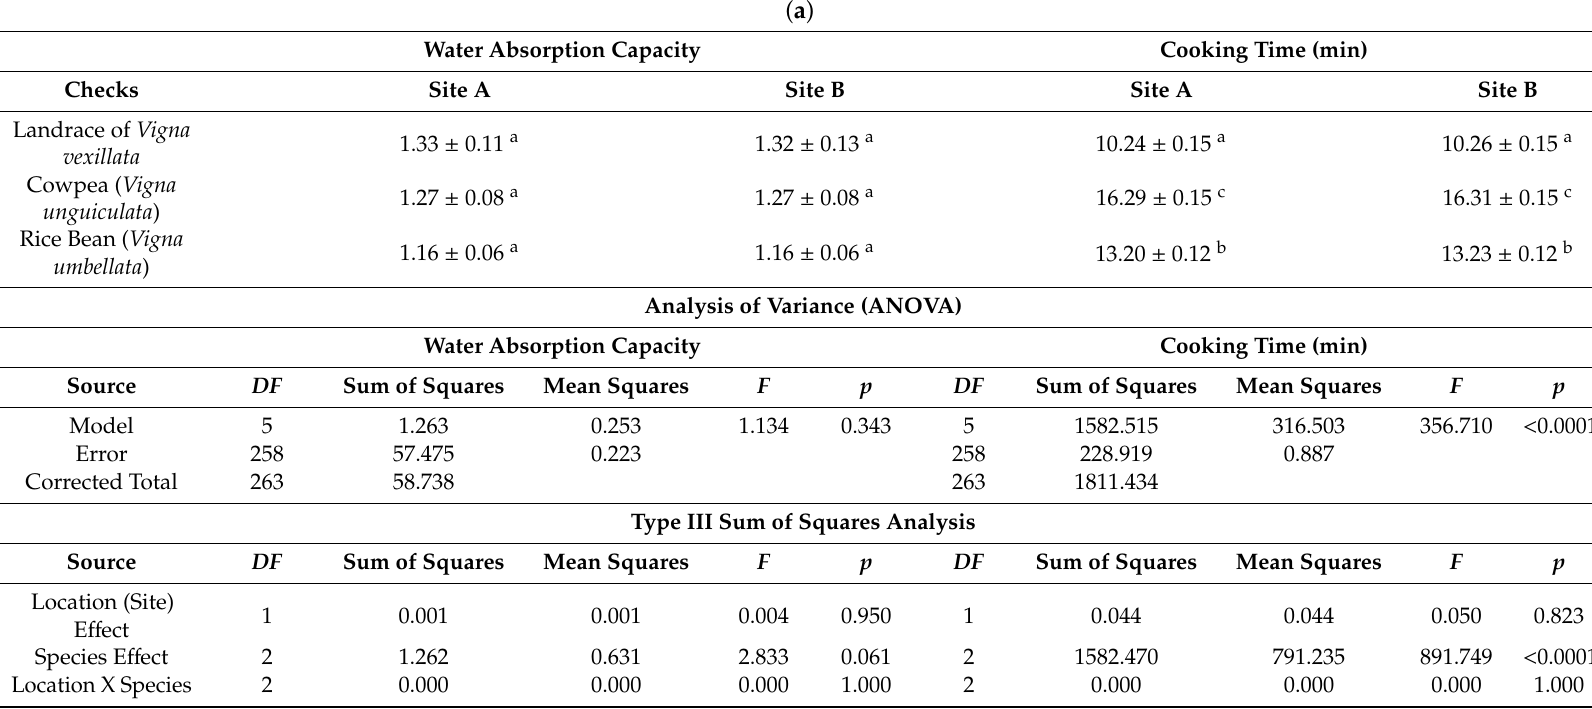
Table 2. Results of the cooking time and water absorption capacity for the domesticated legume seeds. ( a ) Means, analysis of variance and type III sum of square analysis for the cooking time and water absorption capacity traits of domesticated legume seeds. ( b ) Details of interactions within locations e ff ects for water absorption capacity trait. ( c ) Details of interactions within locations e ff ects for cooking time